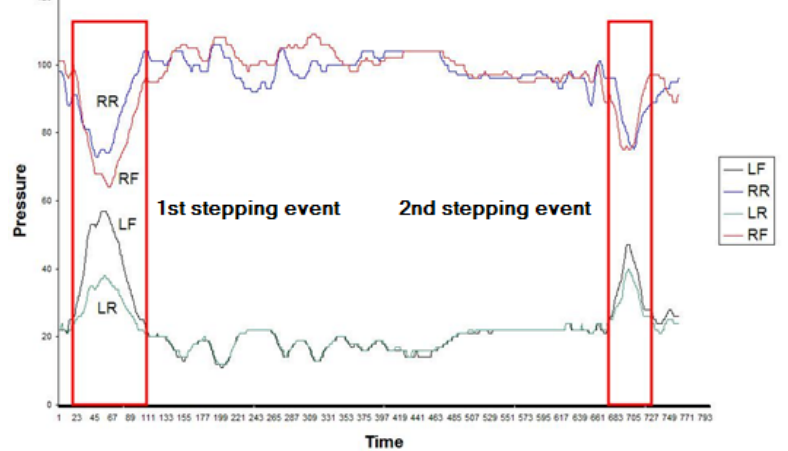
Figure 13. US assessment protocol time series highlighting two stepping